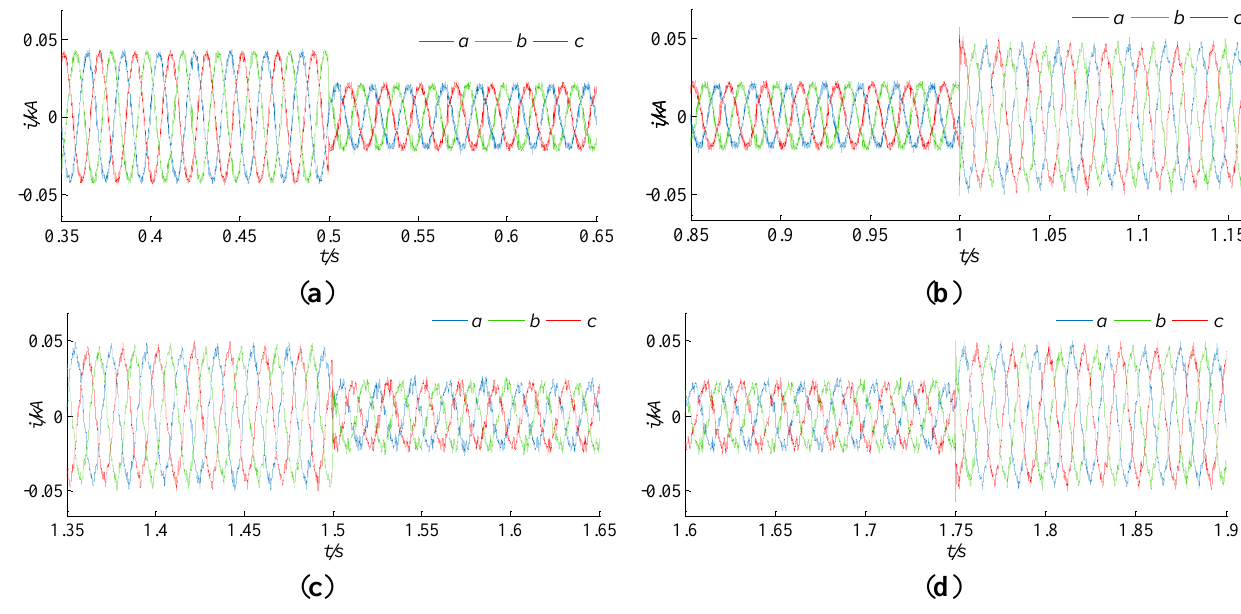
Figure 8. ( a ) Current waveforms of the MSC between 0.35 s and 0.65 s; ( b ) Current waveforms of the MSC between 0.85 s and 1.15 s; ( c ) Current waveforms of the MSC between 1.35 s and 1.65 s; ( d ) Current waveforms of the MSC between 1.6 s and 1.9 s.